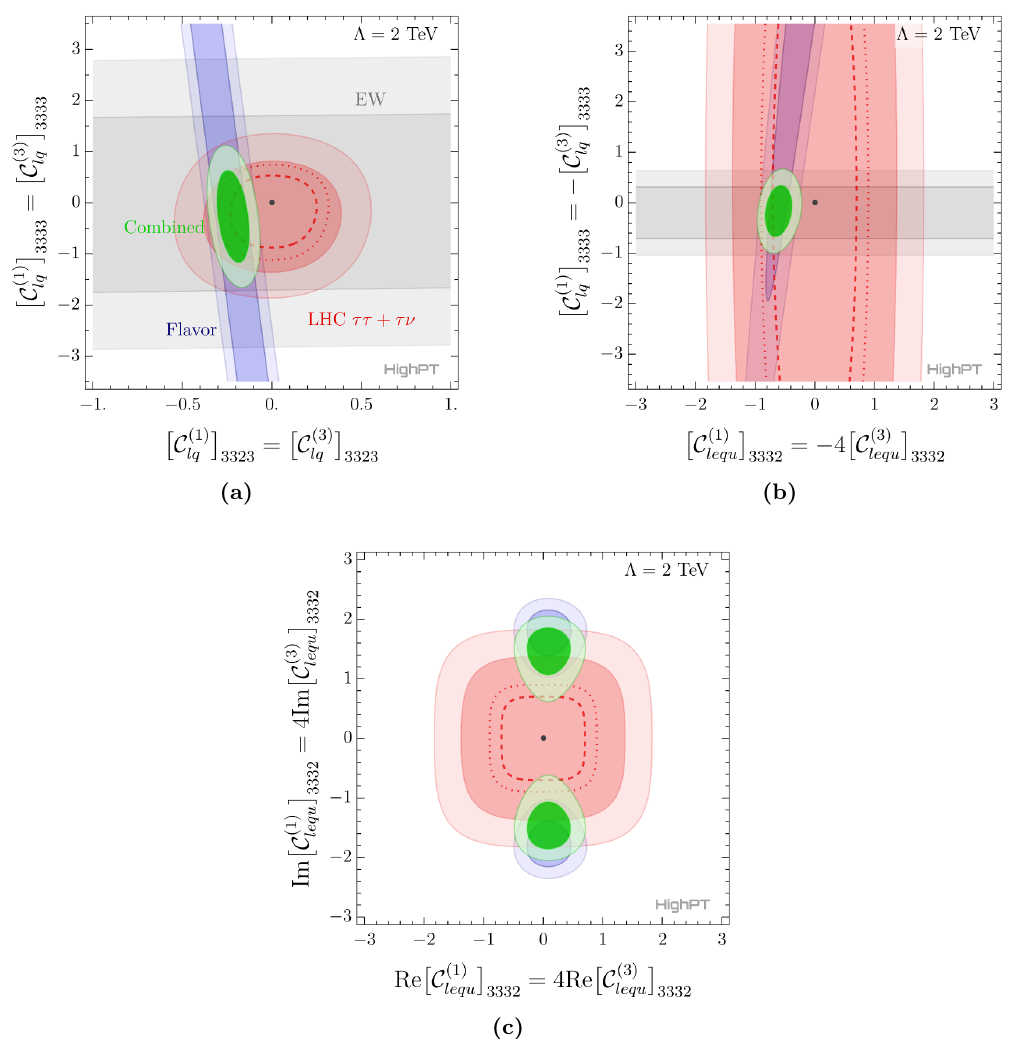
Figure 12. Constraints on the SMEFT coefficients from flavor-physics (blue region), electroweak- precision (gray) and high- p LHC observables (red). The combined fit is shown in green. For each T type of observables, we show the 1 σ ( 2 σ ) regions with darker (lighter) colors. The dashed (dotted) red line indicates the projection of the 1 σ ( 2 σ ) region for an integrated luminosity of 3 ab − 1 . Three effective scenarios are considered which are motivated by different leptoquark models, as explained in the text. The EFT cutoff is set to Λ = 2 TeV and the minimum values for the combined χ 2 in our fits are given by χ 2 = 28 . 3 ( a ) , 29 . 5 ( b ) , 78 . 0 ( c ) min